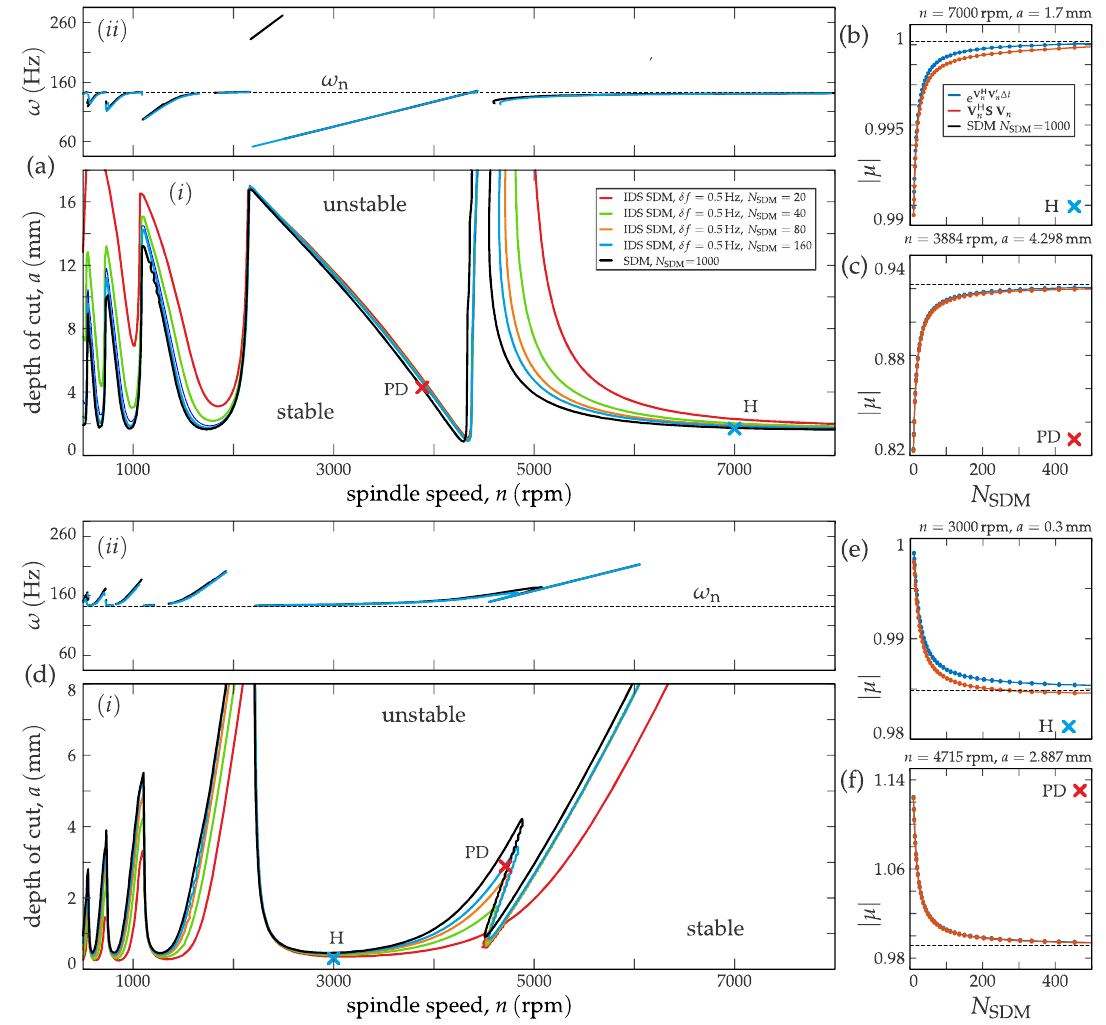
Figure 3. Convergence test of the IDS SDM, where “exact” means the classic semidiscretization [12] solution using resolution N SDM = 1000. In both half-immersion down- (DM, ( a )) and up-milling (UM, ( d )) cases, Hopf- (H, ( b , e )) and period-doubling (flip, PD, ( c , f )) types of points were tested for convergence. The SLDs are presented in subplot (i), while their corresponding vibration frequency charts in subplot (ii). For all cases, the convergence of exponential matrix dynamics (e V H n V (cid:48) n ∆ t , (21)) and shifted product ( V H n S V n , (22)) cases were